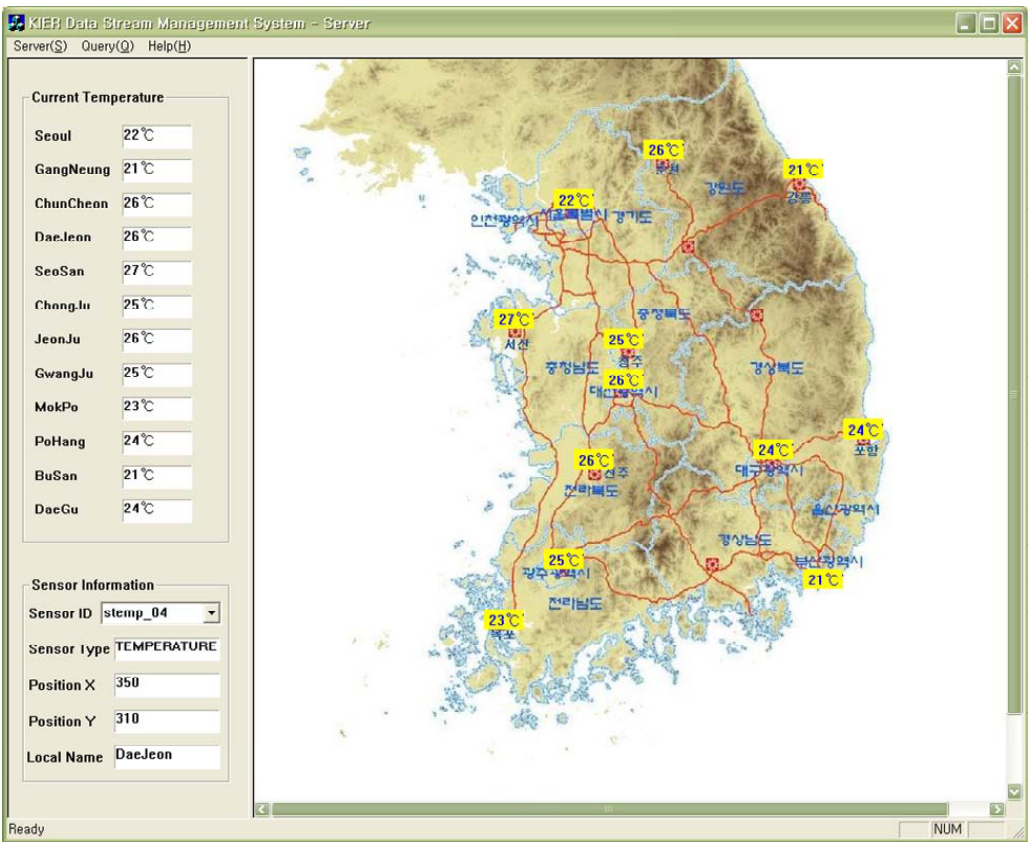
Figure 9. System interface for climate monitoring.